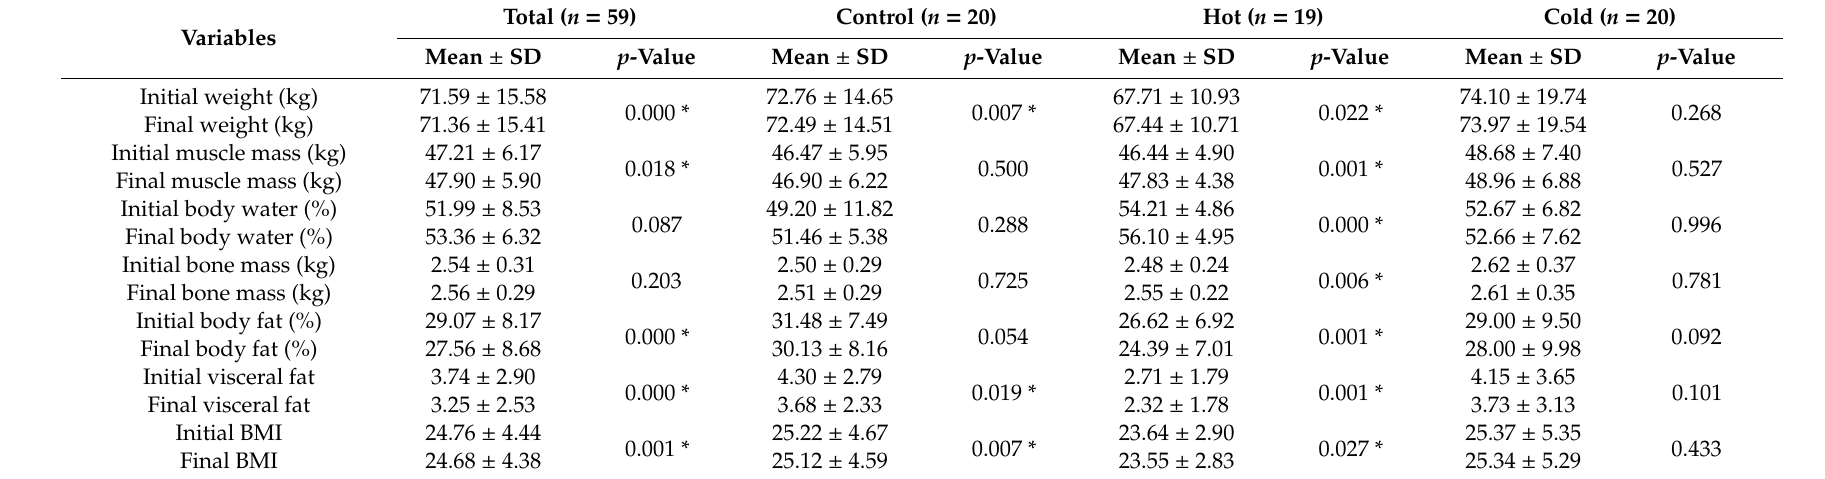
Table 3. Anthropometric measurements (weight, bone mass, muscle mass, body water, body fat, visceral fat, BMI) before starting and after finishing the test, considering the environmental